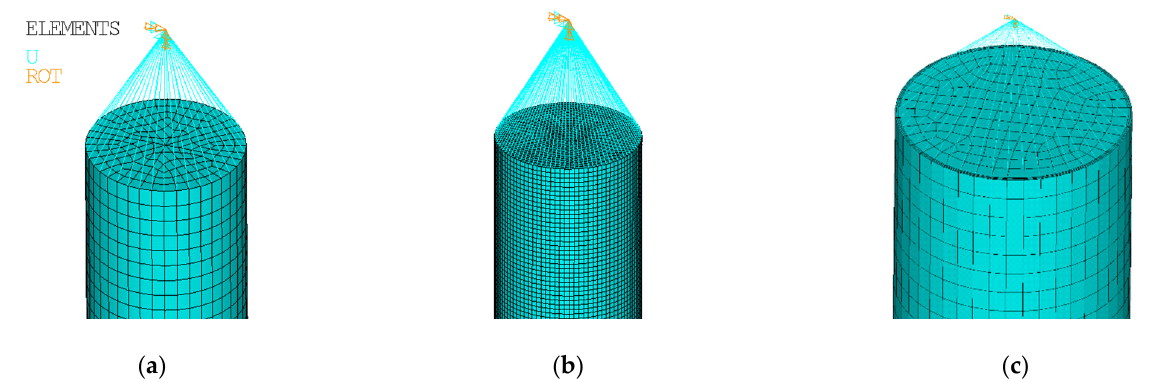
Figure 1. Mesh geometry examples for various modeling approaches: ( a ) #A, shell model, default mesh (88.9 × 2.6-400-P) [38]; ( b ) #B shell model, finer mesh (88.9 × 2.6-400-P) [38]; and ( c ) #D, solid model, default mesh (104 × 2-3080-P) [38].